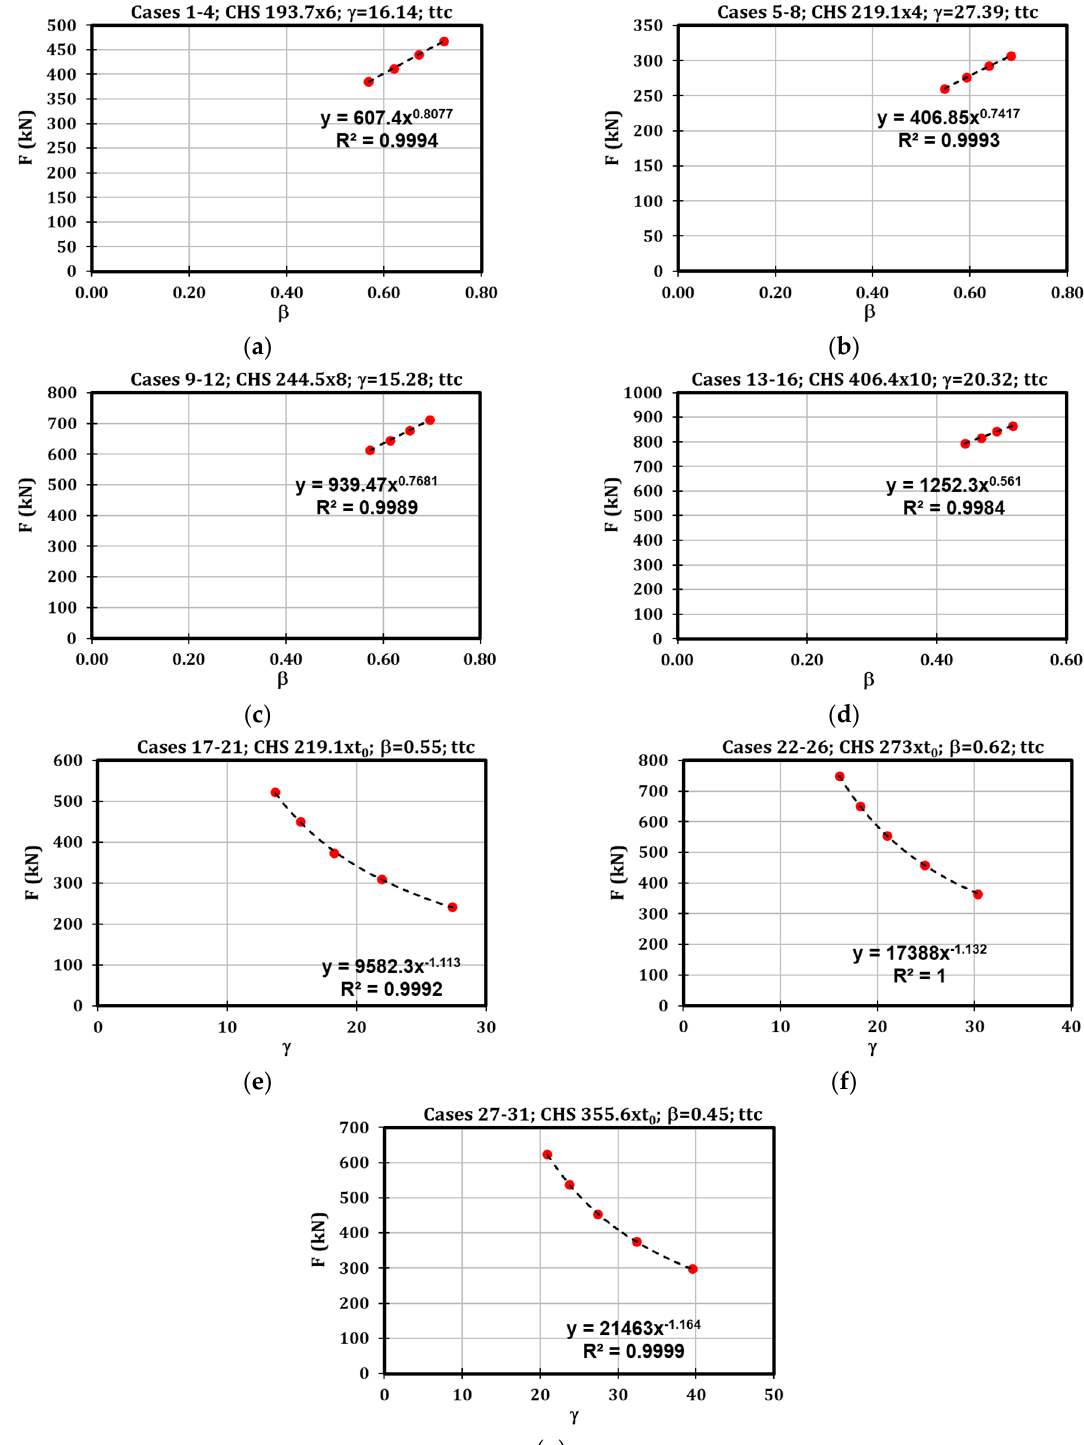
Figure 12. Results of the parametric analysis referred to F ttc . To define a formula for the prediction of the resistance of this component, a regression study was performed referring to the dimensionless parameters 𝐹 (cid:3047)(cid:3047)(cid:3030) /(𝑏 (cid:2869) 𝑡 (cid:2868) 𝑓 (cid:3052) ) versus 𝛽 and 𝛾 . The regression analysis led to Equation (7).